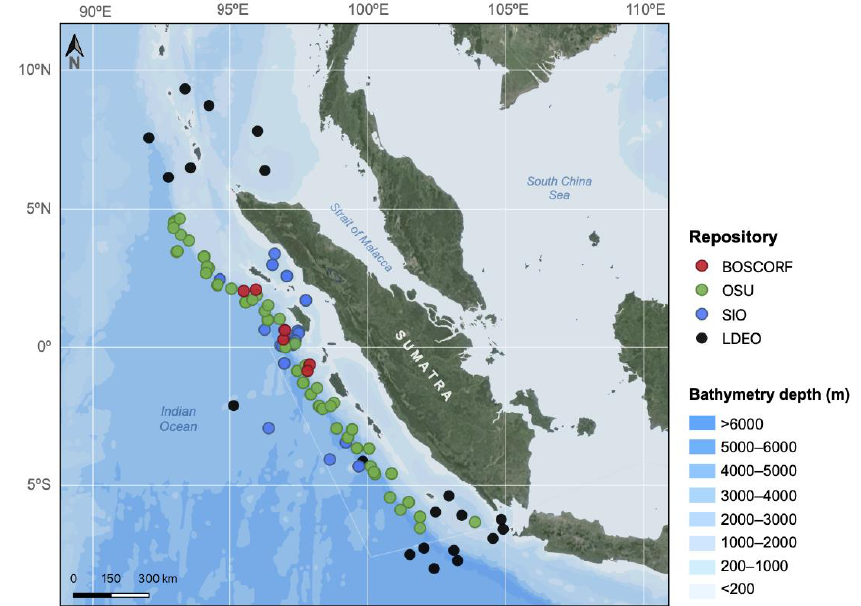
Figure 5. Map of existing marine sediment cores off the island of Sumatra (Western Sunda Volcanic Arc) from www.ncei.noaa.gov/maps/sample_index/ (accessed on 18 March 2023). Core repositories listed are: Oregon State University (OSU), the Scripts Institution of Oceanography (SIO), BOSCORF (British Ocean Sediment CORe Facility), and the Lamont – Doherty Core Repository (LDEO). The only local marine core study of volcanic deposits to date sampled visible tephra layers in 17 marine cores off the western coast of Sumatra and revealed evidence of five previously unknown major explosive eruptions within the last 35 kyrs [29]. No cryp- totephra work has yet been undertaken — this would significantly augment the eruptive record. While the region does not host many long IODP, DSDP, or ODP cores, a multitude of shorter cores gathered from smaller cruises (Figure 5) are already available. An existing regional tephrostratigraphy comprising 20 dated deposits [58] could provide an initial chronological framework for the generation of more detailed eruption histories of indi- vidual volcanoes. 4. Marine Tephra to Inform and Mitigate Global Volcanic Hazards A key challenge for volcanology is to identify volcanoes capable of large-magnitude eruptions, with a potential for a global impact on the climate and civilization [59]. If such volcanoes can be identified, increased monitoring efforts and preparedness may help to mitigate a significant amount of risk to these regions and forewarn of global cascading hazards [56]. Currently, the global frequency of such very large eruptions is estimated by measuring sulphate peaks in dated ice core records from both the northern and southern hemispheres. Approximate recurrence estimates for eruptions equivalent to Magnitude 7 are 625 years [60] over a 60,000-year timeframe, and are even shorter (444 years) since the